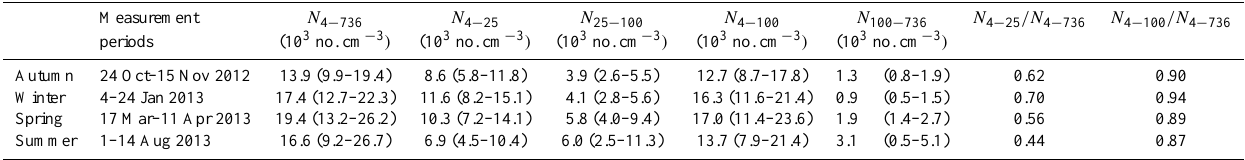
Table 1. Median and quartile ranges (Q1–Q3) of the PNCs measured in each season. The size ranges of the PNCs are represented by the subscripted number. For example, N 4 − 25 represents the number concentrations of the particles from 4 to 25nm. The fractions of N 4 − 25 and N 4 − 100 of total PNCs are presented in the last two